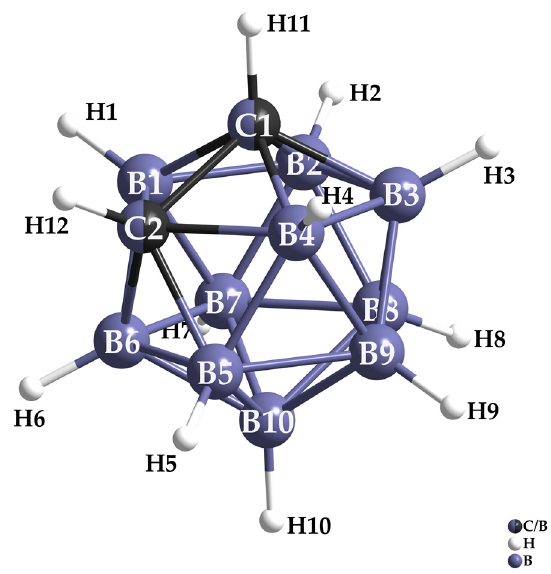
Figure 1. Atom-numbering scheme of the [CB 11 H 12 ] − anion in Tl[CB 11 H 12 ] with the atomic positions C1, C2, B1–B10, H1–H10, H11 and H12, where due to the orientational disorder only one of the two carbon sites is occupied at a time.